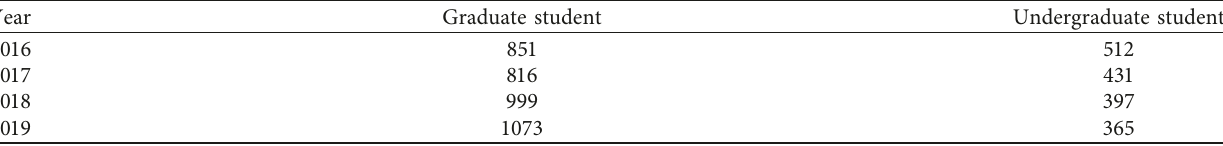
Table 8: The employment data from Harbin Engineering University in the aerospace and other defense-related industry.